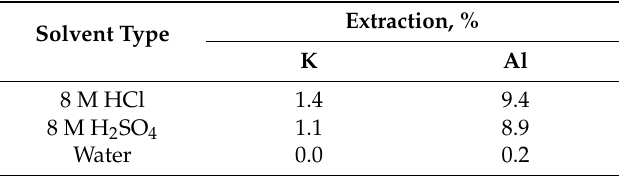
Table 2. K and Al recoveries after direct leaching